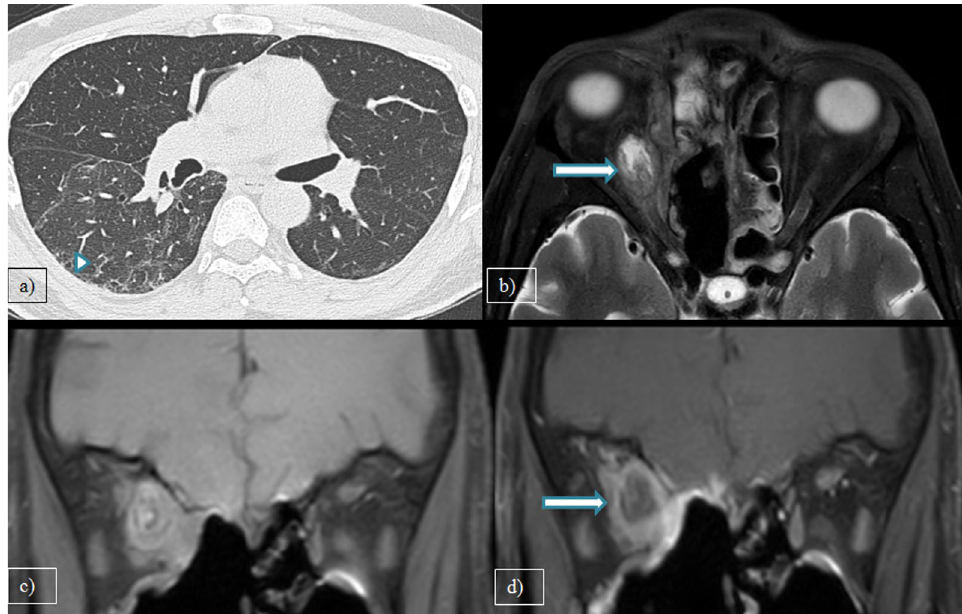
Fig. 7 a Axial HRCT thorax, b MRI Axial T2W-FS, c coronal pre-contrast T1W-FS and d coronal post-contrast T1W-FS images of a 50 years old male patient with complaints of ophthalmoplegia and ocular pain showing patchy peripheral fibrotic changes with superimposed ground glass opacities (arrowhead) and peripherally enhancing intraconal abscess in the right orbit(arrow). Bilateral ethmoidal sinusitis is also